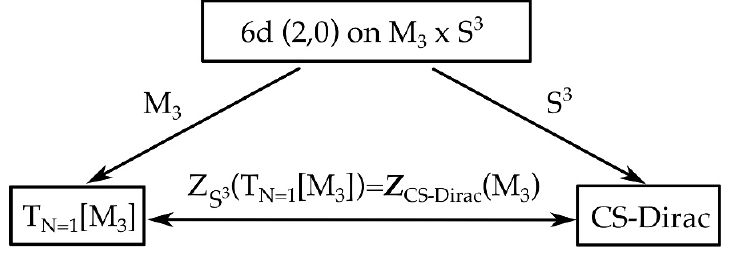
Figure 2 . The setup for the N = 1 3d-3d correspondence is the 6d (2 ; 0) theory on M 3 (cid:2) S 3